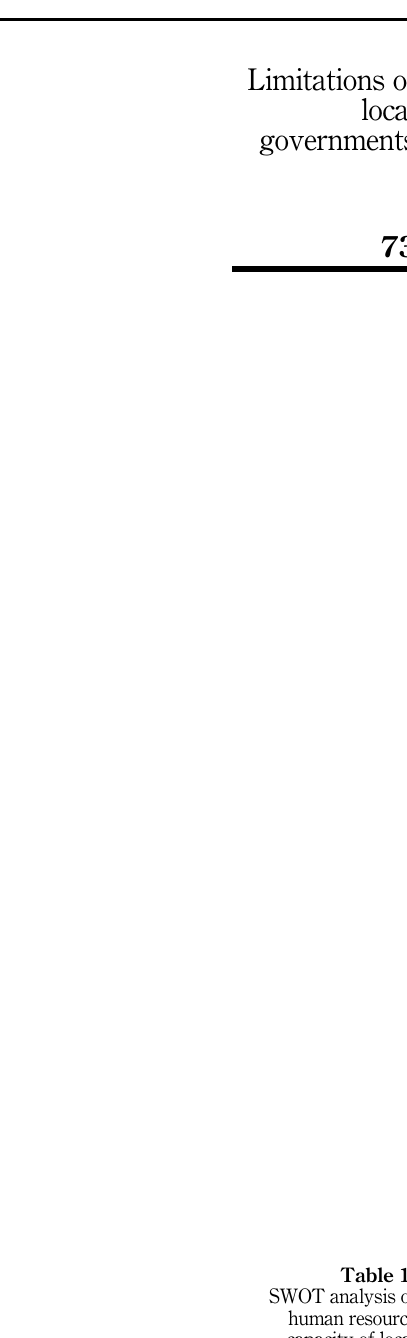
Table 1. SWOT analysis of human resource capacity of local